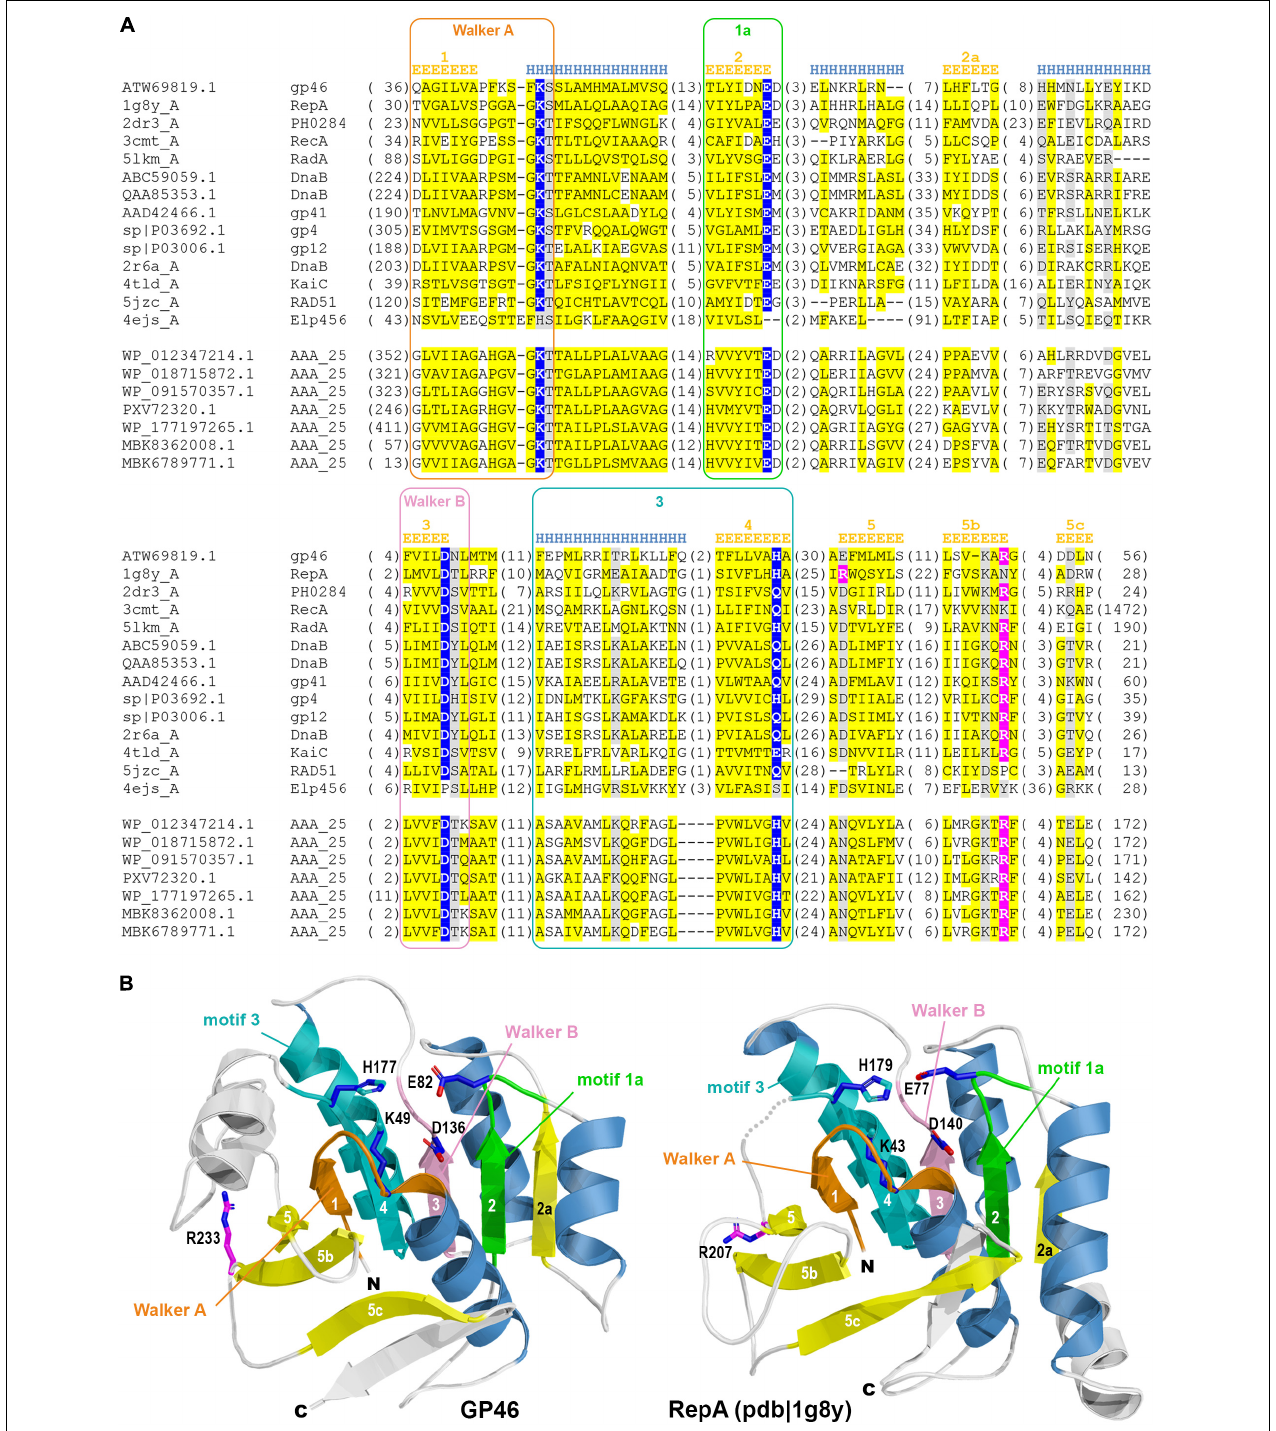
FIGURE 2 | (A) Multiple sequence alignment of GP46 F 13 and the representatives of related families. Sequences are labeled with GenBank accession number, Uniprot ID, or PDB code. Sequence conservation is denoted with yellow and gray highlighting for non-polar and charged or polar residues, respectively. The numbers of residues omitted in the alignment are provided in parentheses. Residues involved in NTP hydrolysis are highlighted with blue, and the arginine from arginine finger–in pink. Sequence motifs are outlined with rectangles. Secondary structure elements are labeled according to James M Berger’s summary on helicase structures (Berger, 2008). (B) Comparison between 3D model of GP46 F 13 (left) and structure of the RepA (pdb| 1g8y). Non-core structural elements not present in the alignment (A) are rendered in white. Structural elements corresponding to defined motifs are colored in respective colors.